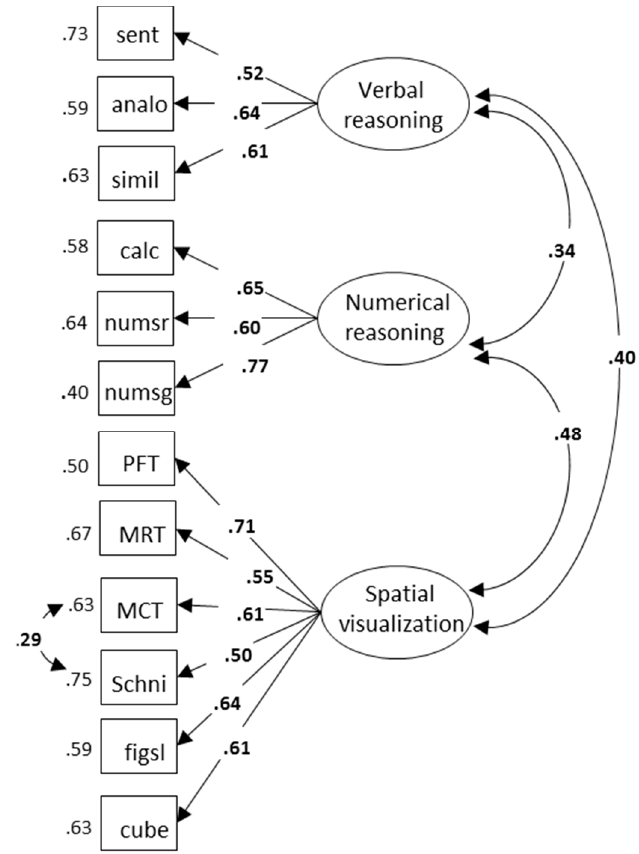
Figure 1. Three correlated factors model of cognitive abilities. Sent = Sentence completion; Analo = Analogies; Simil = similarities; Calc = Calculations; Numsr = Number series; Numsg = Numerical signs; PFT = Paper Folding Test; MRT = Mental Rotations Test; MCT = Mental Cutting Test; Schni = Schnitte; Figsl = Figure selection. All paths are significant at p < 0.001.